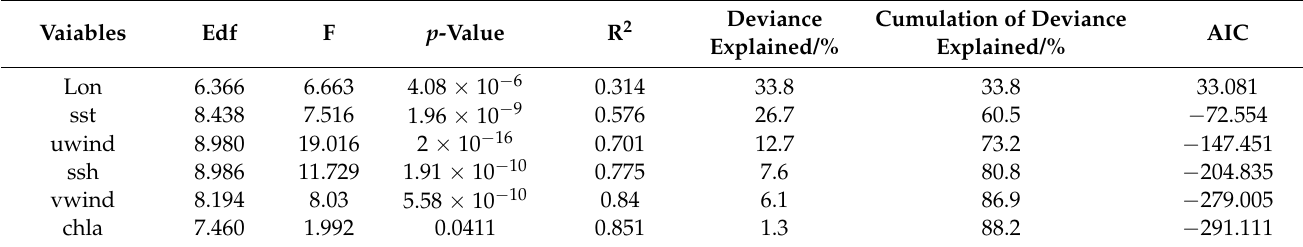
Table 6. Result of GAM